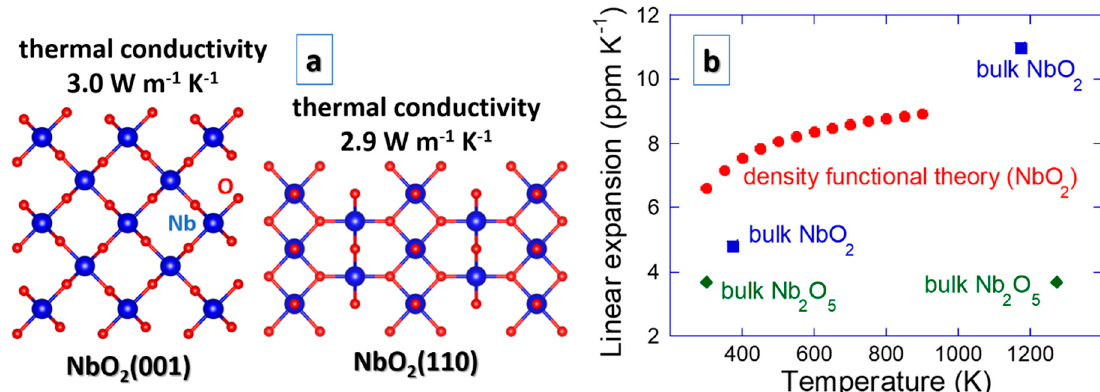
Figure 6. Thermal properties of NbO 2 , including ( a ) thermal conductivity for two orientations [91] and ( b ) linear coefficient of thermal expansion obtained theoretically [92] and experimentally [20]. Due to a lack of other values, a comparison is made with the available expansion data on Nb 2 O 5